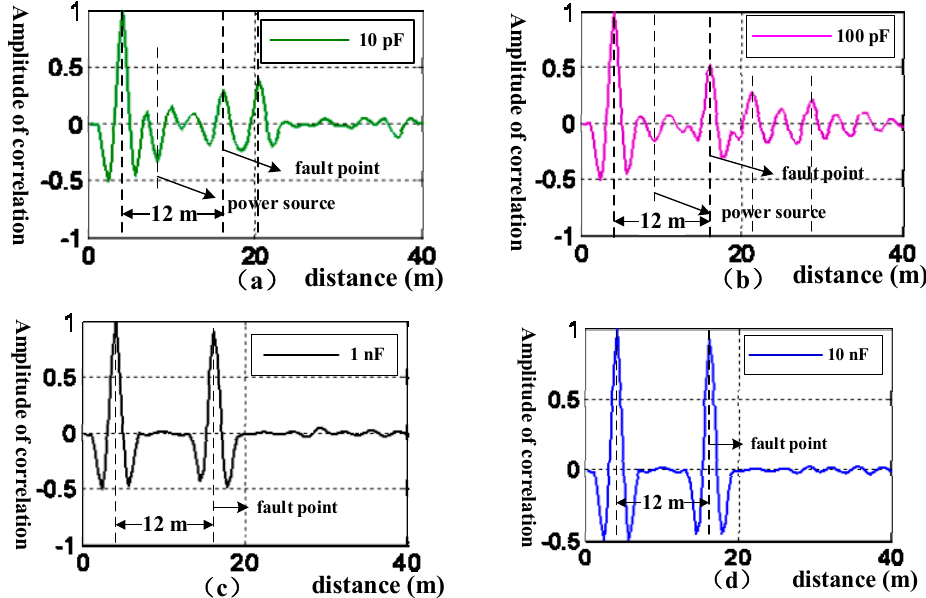
Figure 6. Diagram of cable fault diagnosis with different values of capacitance. ( a ) The trapper with capacitance of 10 pF. ( b ) The trapper with capacitance of 100 pF. ( c ) The trapper with capacitance of 1 nF. ( d ) The trapper with capacitance of 10 nF.